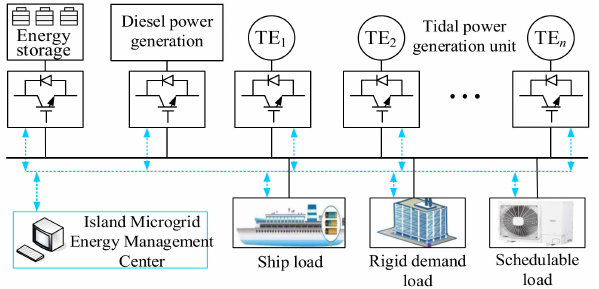
Figure 1. Schematic diagram of an island microgrid power supply and distribution